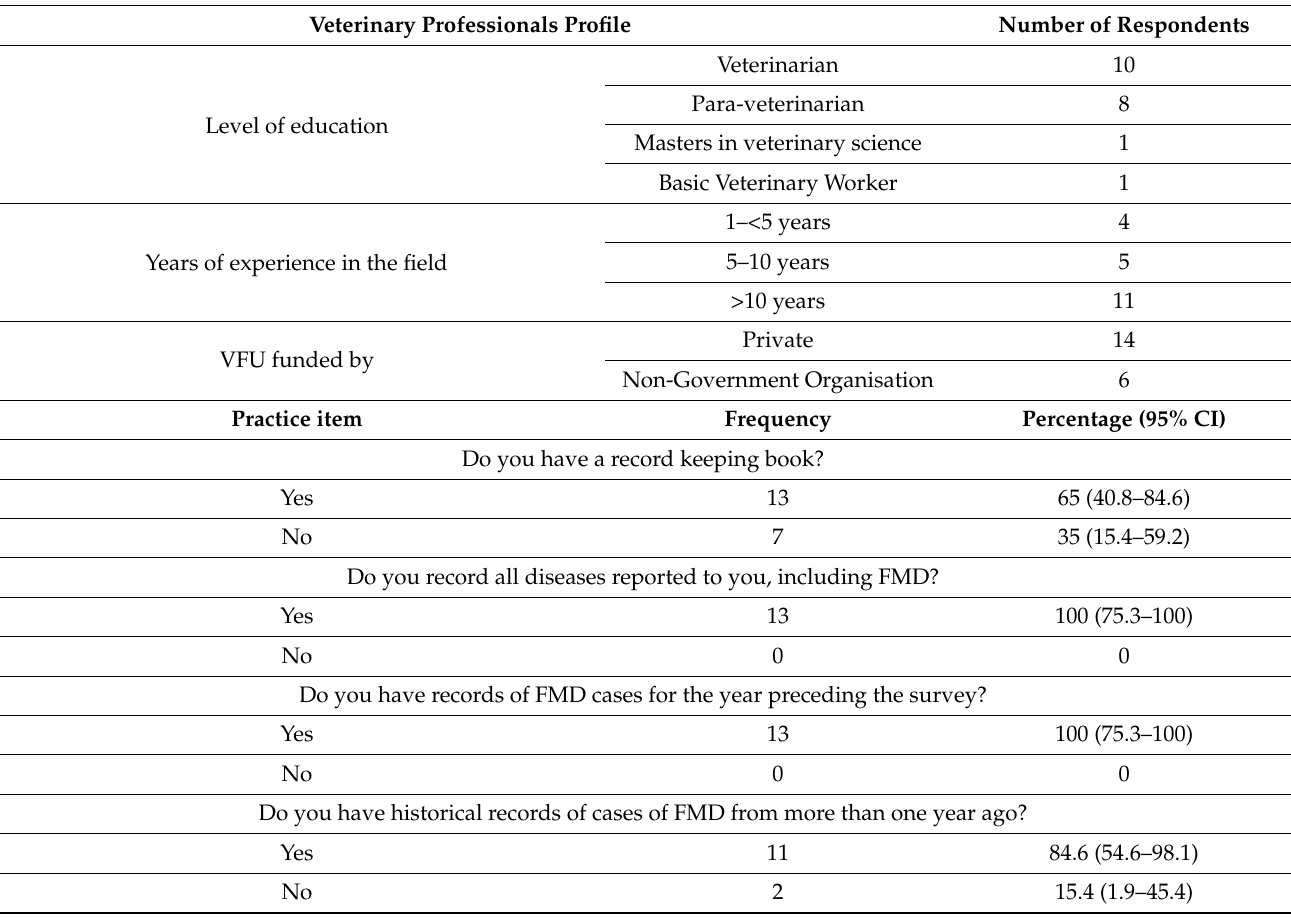
Table 4. Local Veterinary professionals’ profile activities on foot and mouth disease (FMD) in the study